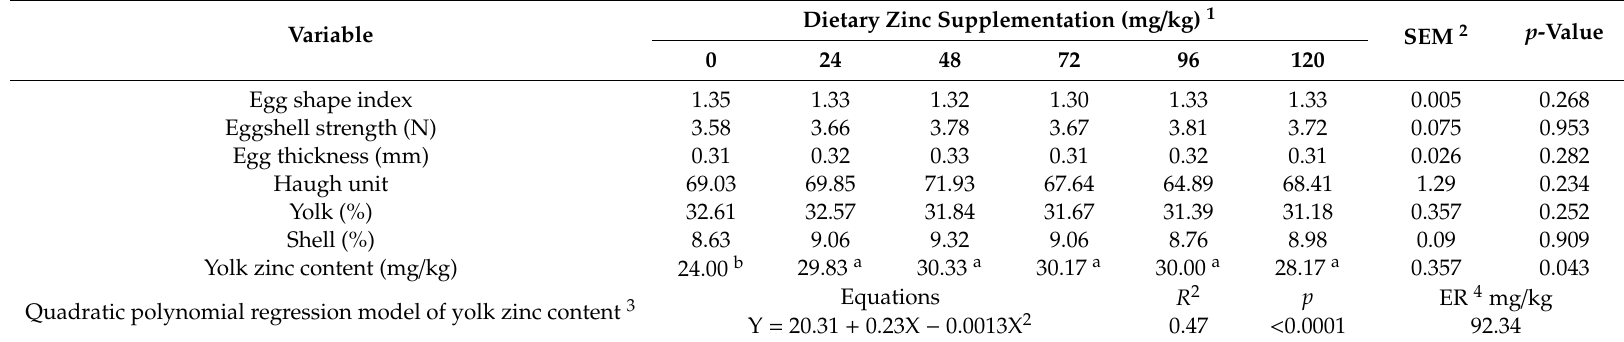
Table 3. E ff ects of dietary zinc supplementation on egg quality of yellow-feathered broiler breeders aged 58 to 65 weeks.